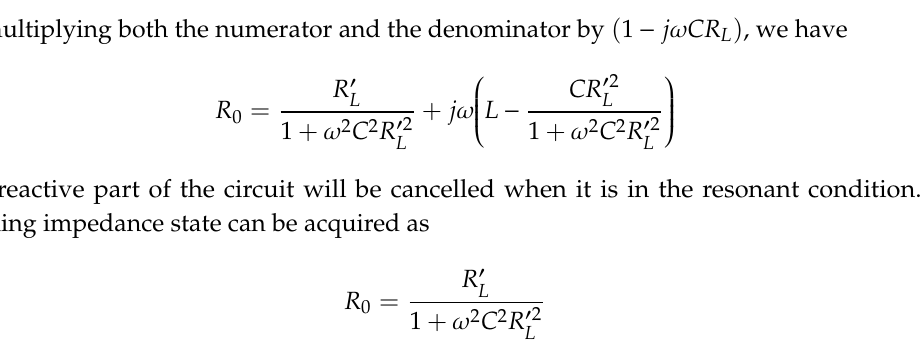
Figure 5. Circuit model for impedance analysis.